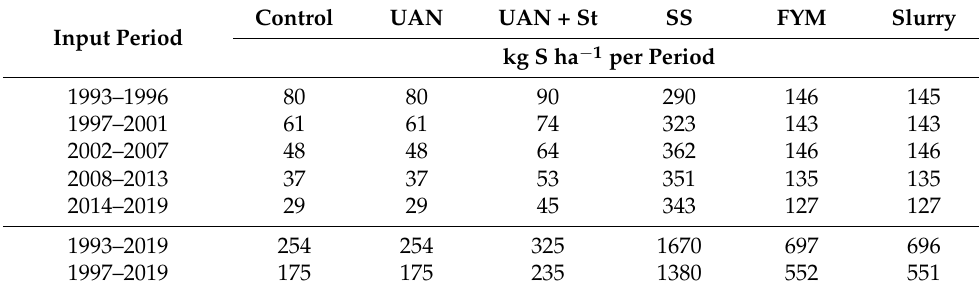
Table 4. Total sulfur inputs (depositions and fertilizer) during the